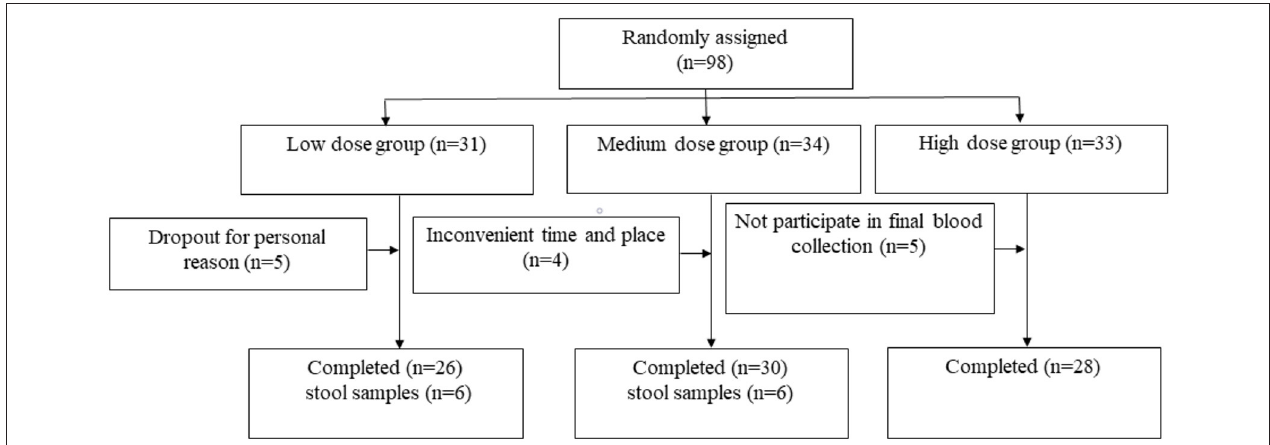
FIGURE 1 | Flow diagram of participant progress through the study. 1 means nine participants provided samples before the intervention, three participants lose after the intervention, six participants from the Low group provided samples both before and after the intervention finally. 2 means seven participants provided samples before the intervention, one participant lose after the intervention, six from the Medium group provided samples both before and after the intervention finally. 3 means five participants provided samples before the intervention, all participants lose after the intervention, there are no complete samples finally in the High group.